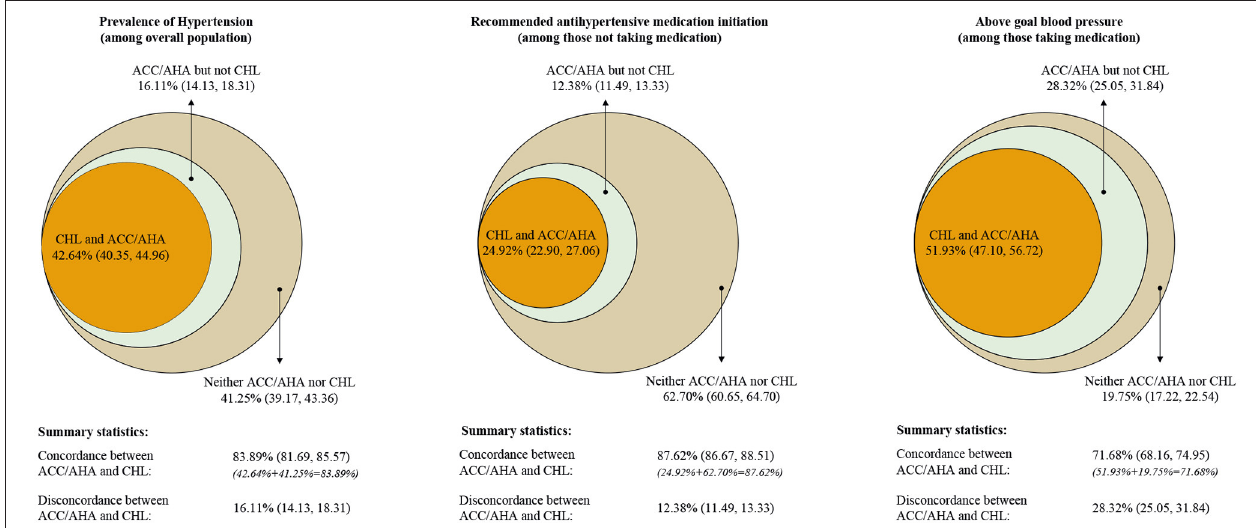
FIGURE 1 | Percentage of hypertension, recommended to initiate antihypertensive medication, above-the goal blood pressure. Data used for estimating was from CHARLS 2011–2012 baseline survey. (Left) Percentage of Chinese adults who have hypertension; (Middle) percentage of Chinese adults who are recommended to initiate antihypertensive medication among those not taking antihypertensive medication; (Right) percentage of Chinese adults with above the goal blood pressure among those taking antihypertensive medication.